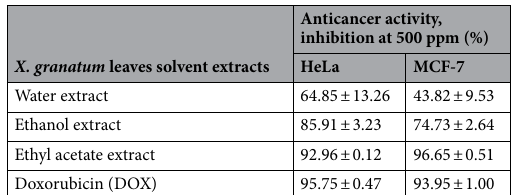
X. granatum leaves solvent